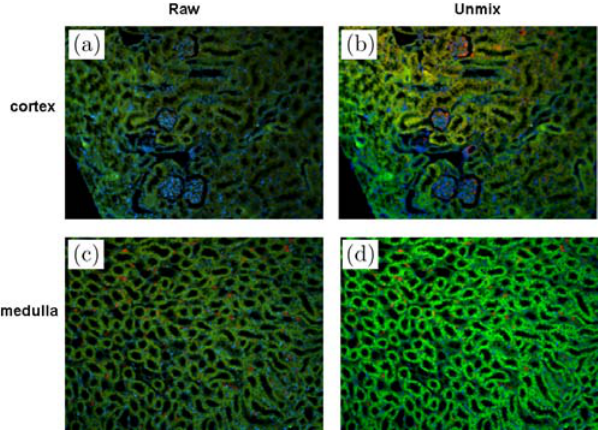
Fig. 3. Fluorescence images of renal cortex and medulla. (a), (c) Raw and (b), (d) processed °uorescence images of kidney cortex (a), (b) and medulla (c), (d) regions after multiplexed °uorescence labeling. The °uorescent probes are DAPI (blue), Dio (green) and Au – Ft (red), as shown in encoded pseudocolors in image (b) and (d). The spectra of each pixel were collected, and \compute pure spectrum" techniques were used to achieve °uorescent signal unmixing and ubiquitous auto°uorescence